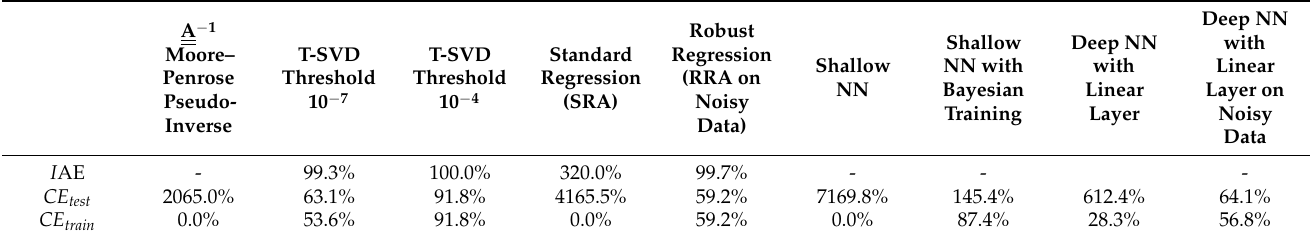
Table 1. Reconstruction errors for different